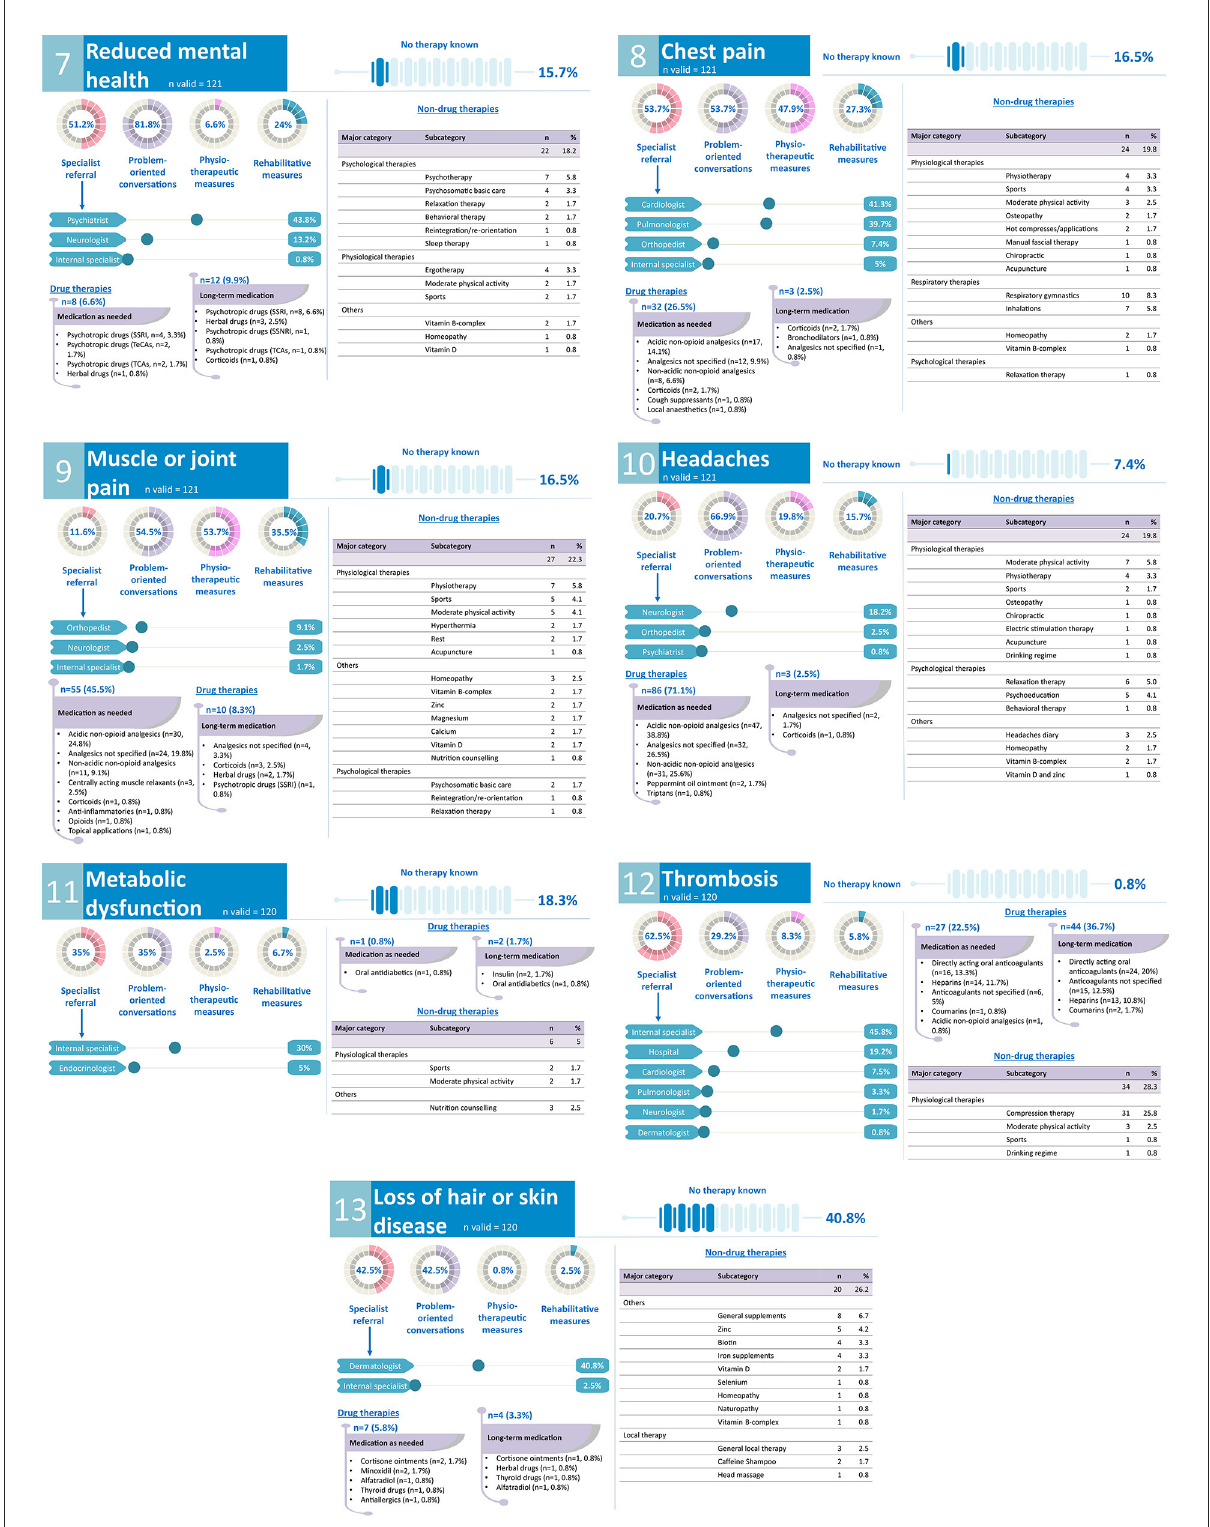
FIGURE5 GPs’ treatment and rehabilitation plans of common long COVID symptoms: reduced mental health, chest pain, muscle or joint pain, headaches, metabolic dysfunction, thrombosis, loss of hair or skin disease. SSNRI, selective serotonin noradrenalin reuptake inhibitor; SSRI, selective serotonin reuptake inhibitor; TeCAs, tetracyclic antidepressants; TCAs, tricyclic